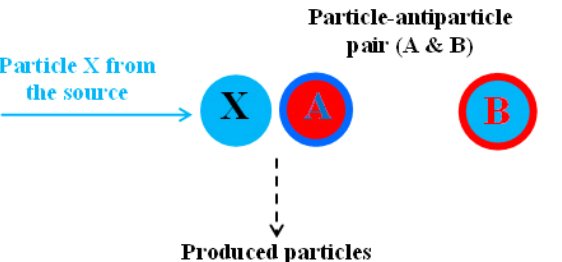
Fig. 1. Schematic diagram for testing the existence of packaged entangled states of particle – antiparticle pairs. If the annihilation rate is 1, then the pairs are in packaged entangled states. If the annihilation rate is 0.5, then the pairs are in separable